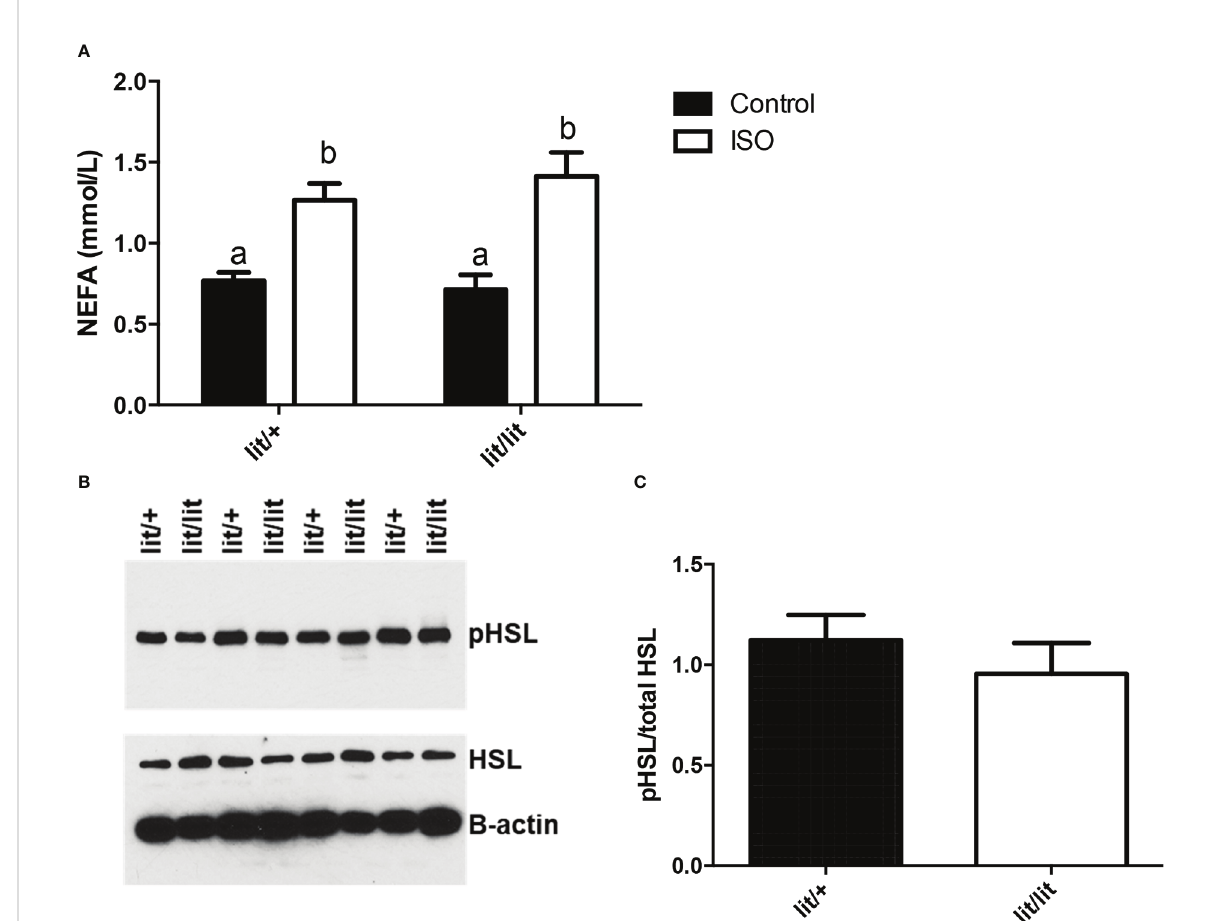
FIGURE 7 Effect of GH de fi ciency on isoproterenol-induced lipolysis in mice. Ad lib-fed Lit/+ mice and lit/lit littermates were intraperitoneally injected with 10 m g/g body mass of isoproterenol (ISO). Blood samples were collected immediately before and 15 min after the injection, and inguinal subcutaneous fat pads were taken 15 min after the injection. (A) Serum concentrations of non-esteri fi ed fatty acids (NEFA). Means labeled with different letters are statistically different ( P < 0.05, n = 4 mice). (B) Western blots of phosphorylated hormone-sensitive lipase (pHSL) and total HSL in adipose tissue. Beta-actin was measured as a loading control. (C) Density ratio of pHSL to total HSL. pHSL/HSL is not different between lit/+ and lit/lit